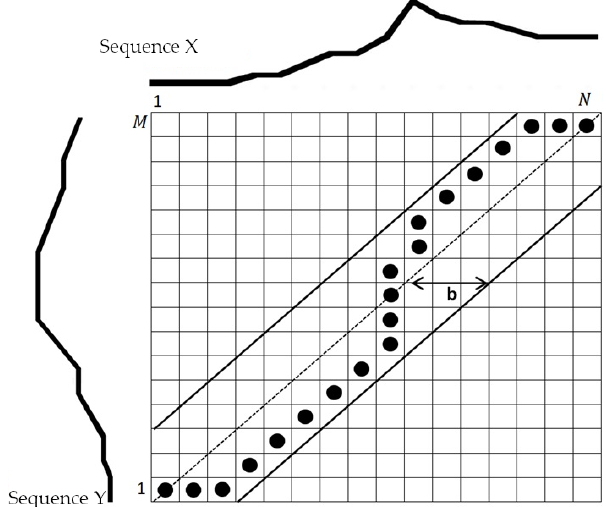
Figure 3. Visualization of the operation of the DTW algorithm with a transformation window width